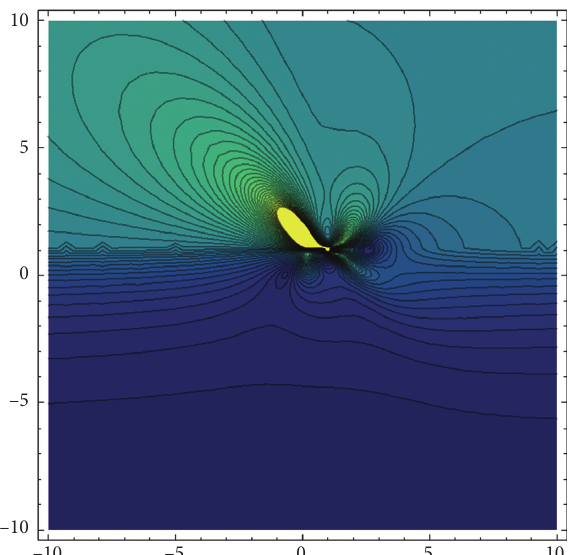
Figure 16: Contours of the asymmetric second-order fractional rogue wave (color online) with α � 5/6 and a � 1 modified from solution (39).